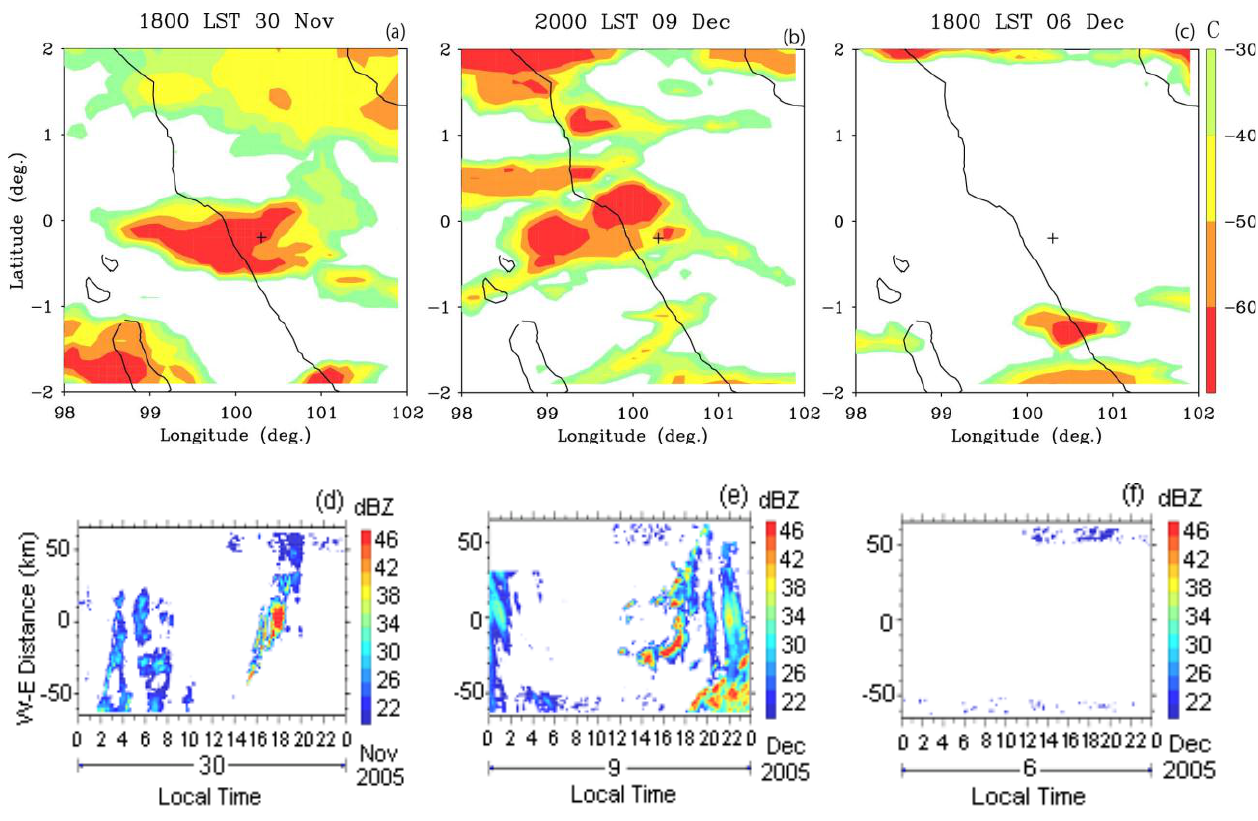
Fig. 1. Satellite (MTSAT – 1R) derived cloud top temperature. The panels are constructed within 2 ◦ N to 2 ◦ S latitude and 98 ◦ E to 102 ◦ E longitude covering EAR site. “ + ” sign denotes location of the radar. Color scale denotes the different temperature ranges. Upper panels show temperature at (a) 18:00LST on 30 November, (b) 20:00LST on 9 December, and (c) 18:00LST on 6 December, while lower panels (d) to (f) show X-band radar reflectivity on 30 November 2005, 9 December 2005, and 6 December 2005, respectively. Data are not shown on 18 December 2005 as no convection was observed and the satellite temperature and X-band reflectivity obtained were similar to (c) and (f) ,